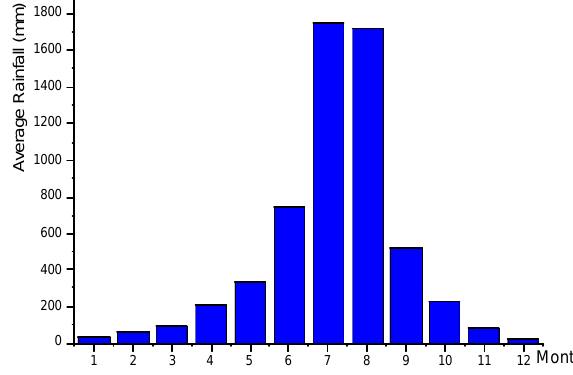
Fig. 2. Average monthly rainfall data series during 1951–2010 of Beijing